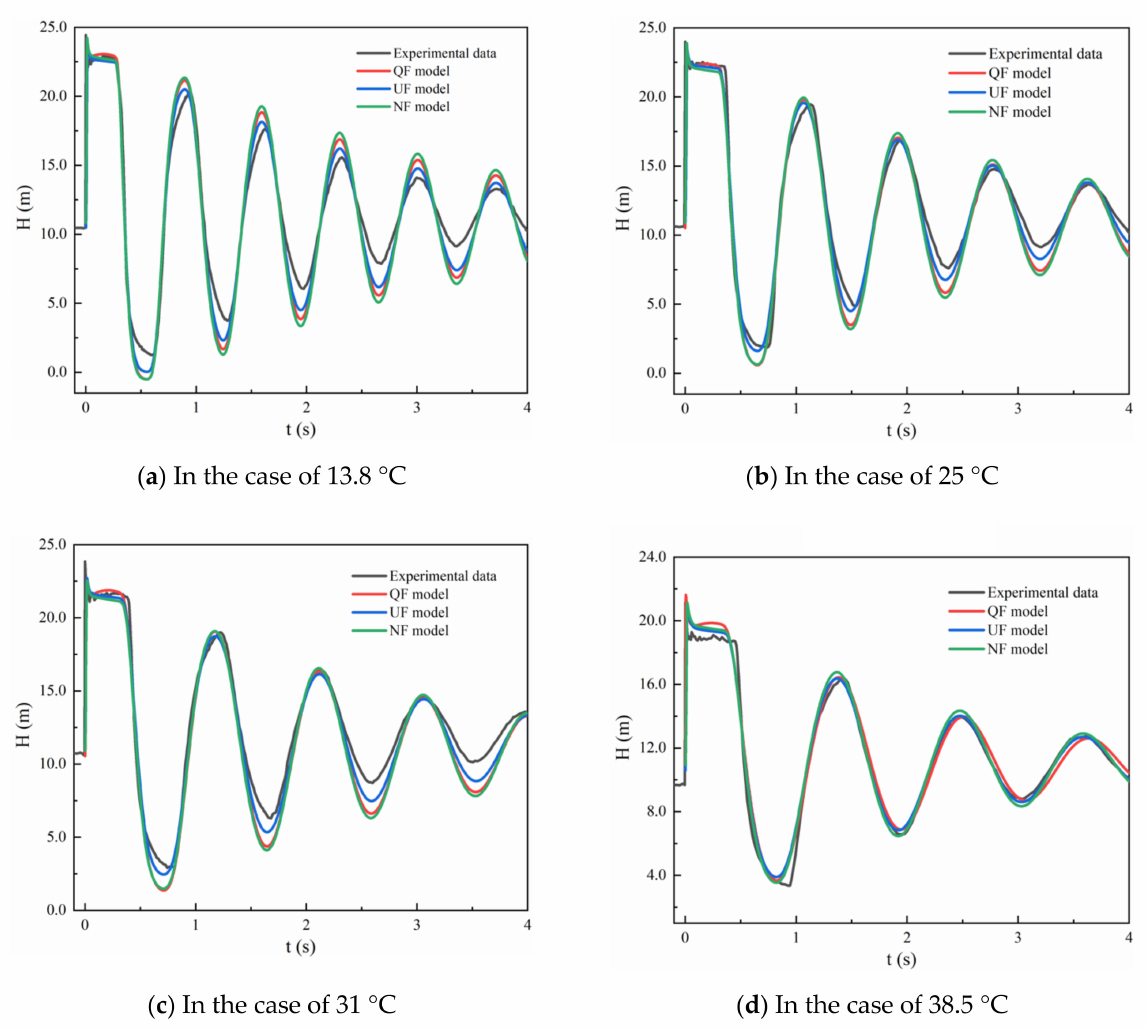
Figure 4. Pressure heads calculated by different friction models at four water temperatures: ( a ) 13.8 ◦ C;